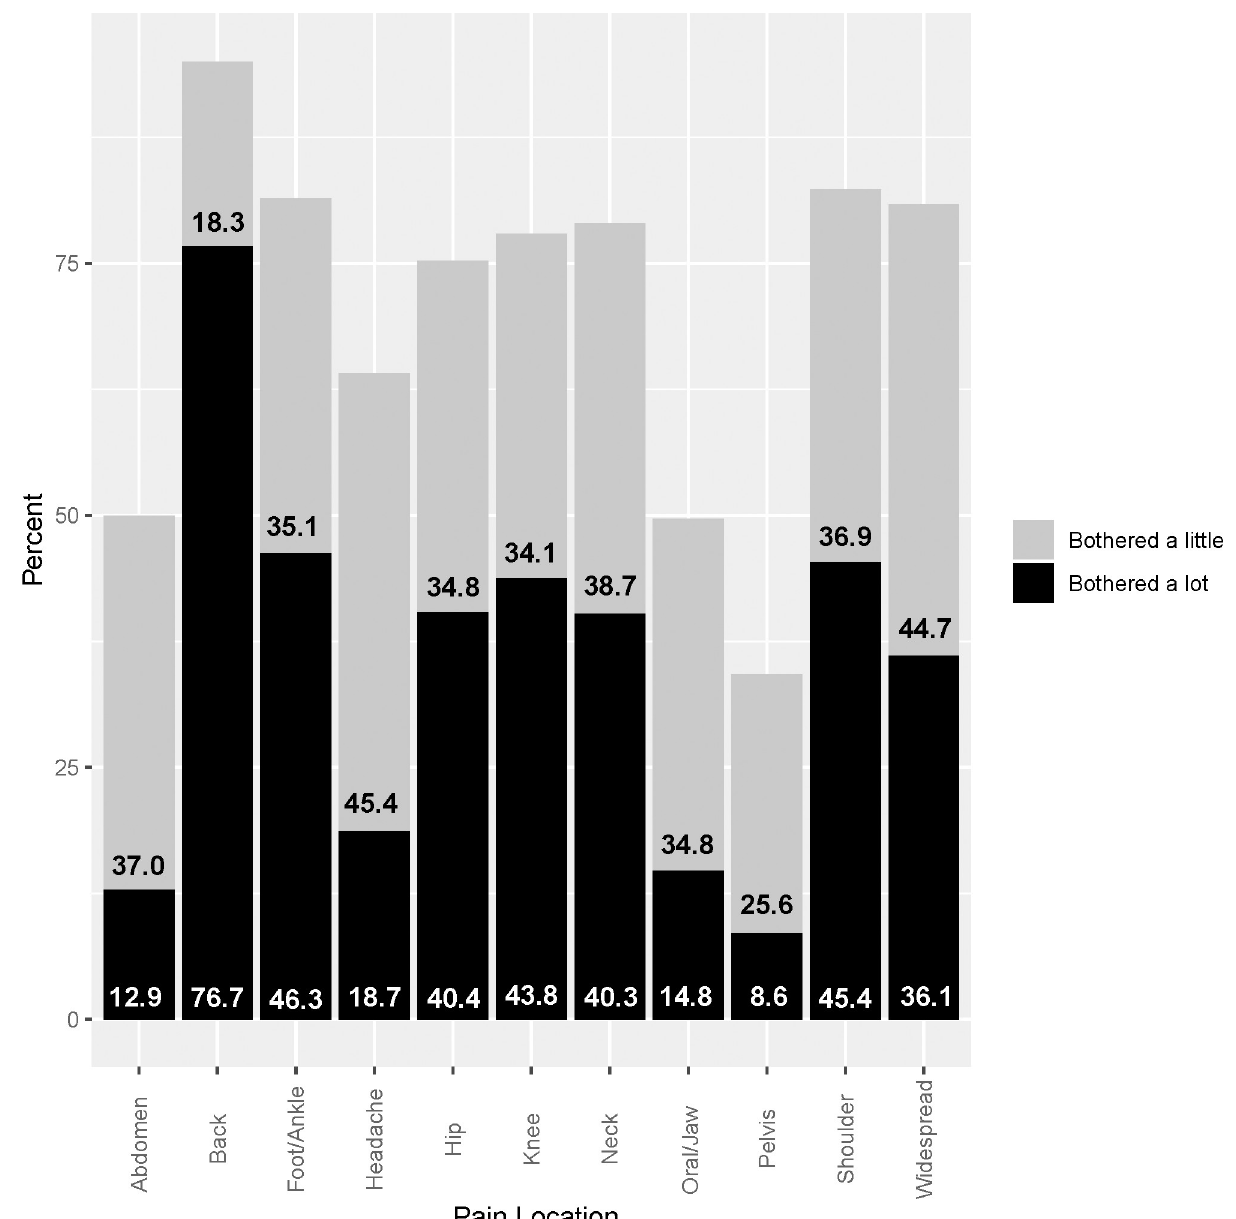
Fig 2. Bothersome pain locations in the past 6 months among survey cohort participants (n = 9074). Values are weighted percentages for each response option. associated with a small decrement in VR-12 mental score (beta coefficient -0.09, p = 0.0236). For patients treated without long-acting opioids, higher daily dosages were significantly associ- ated with worse outcomes; specifically, each additional 10 mg was associated with 0.10-point increase in BPI-I (p < 0.0001), 0.41-point decrease in VR-12 physical (p < 0.0001), and 0.39-point decrease in VR-12 mental (p = 0.0003). Sensitivity analyses limiting the upper dos- age range produced similar results (S5 Table). Table 4 shows outcomes by conventional daily dosage categories for patients with and without long-acting opioids. For participants treated